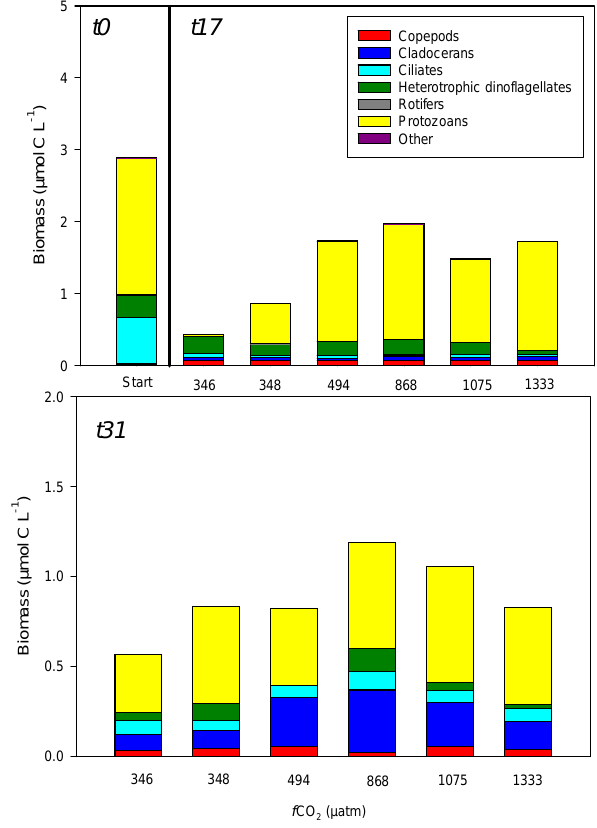
Figure 2. The main micro- and mesozooplankton groups at the start of the experiment, t 0, and t 17 (upper panel) and t 31 (lower panel). The initial period ( t 0) was the average of all mesocosm bags. A more detailed description of the temporal development in the zoo- plankton community can be found in Lischka et al. (2015).